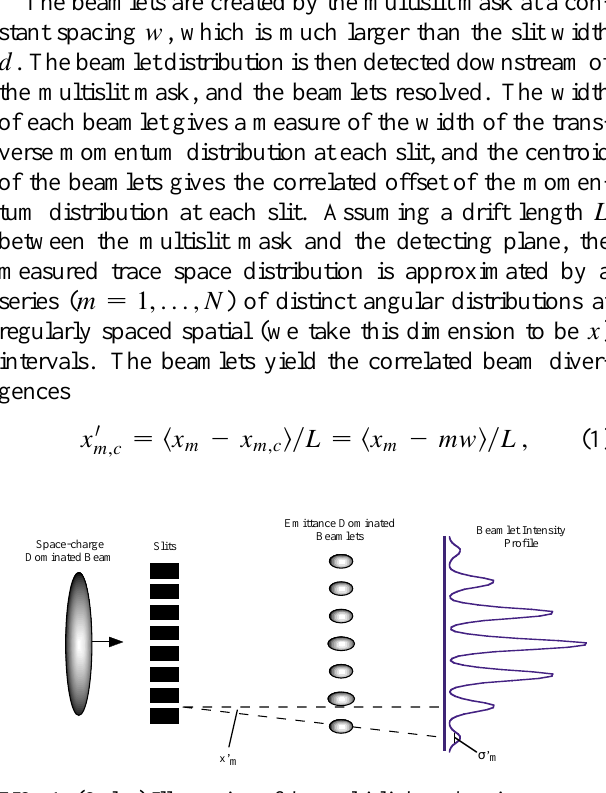
FIG. 1. (Color) Illustration of the multislit-based emittance mea- surement scheme.